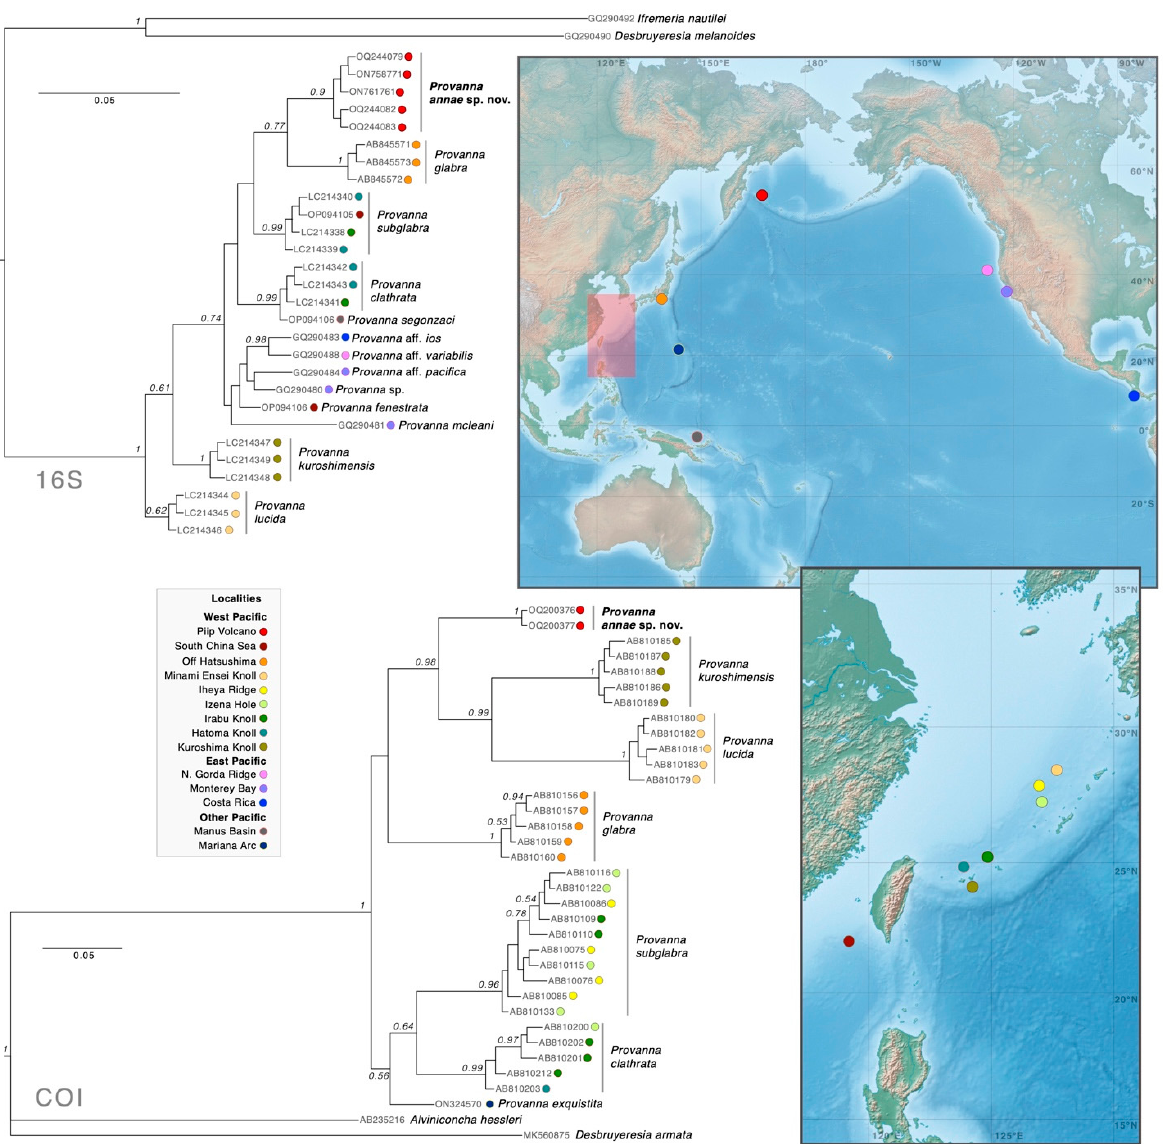
Figure 6. Bayesian phylogenetic trees of Pacific Provanna species, based on 16S and COI sequences. The maps show the geographical distribution of the specimens used in the analysis. Values of posterior probability less than 0.5 are not shown.